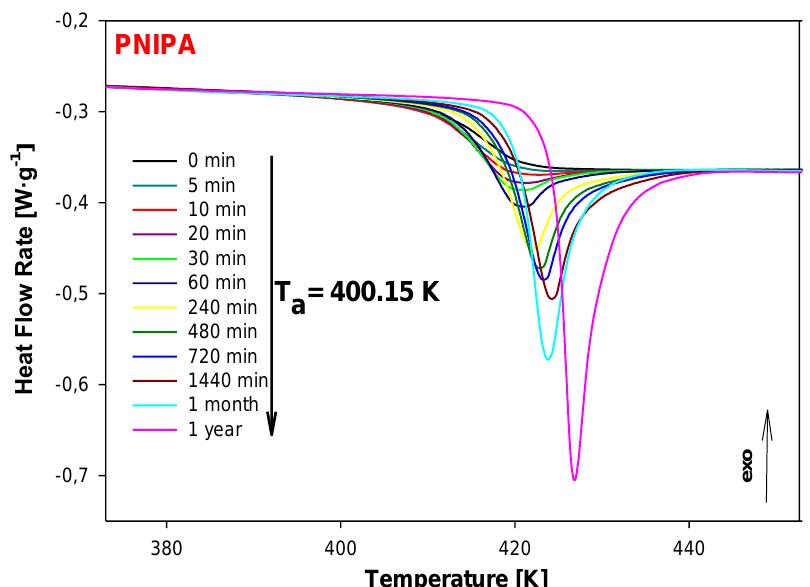
Figure 6. The change of heat flow rate of unaged (t a = 0 min) and aged at T a = 400.15 K of PNIPA versus temperature. The aging time of PNIPA was used in the range of 5 min to 1 year.